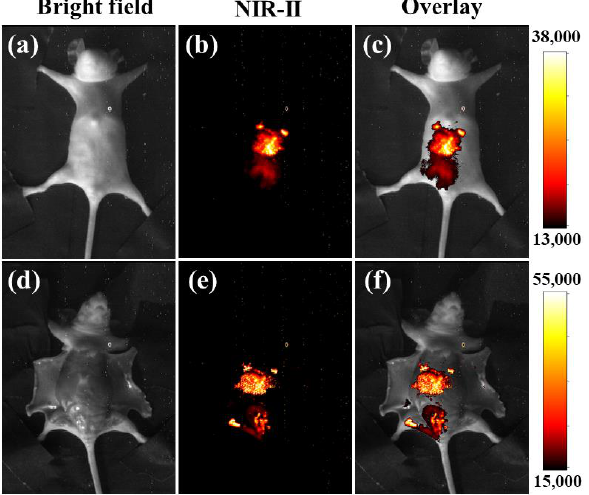
Figure 6. Near-infrared images of mice after injection with NaYF 4 :Yb,Er,Ce@SiO 2 -OAlg. ( a , d ) The image of the bright field of mice. ( b , e ) The luminescent signals were obtained at the 1490 – 1580 nm region under excitation by a 980 nm laser. ( c , f ) Overlay of the NIR-II and the bright field images.